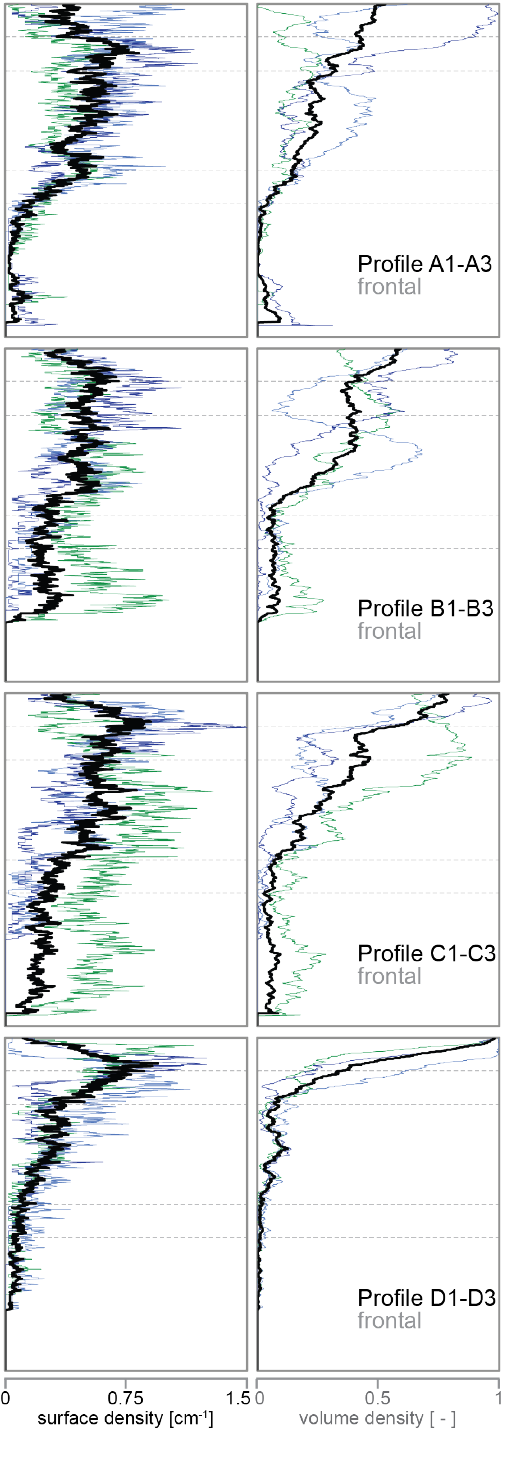
Fig. 7. Numerical representation of the dye-stained soil patterns of the 1m × 1m soil profiles. The integrated frontal profiles A1–A3, B1–B3, C1–C3 are shown on the left, lateral profiles E, F1–F2, G1–G3 and H1–H3 are on the right. Surface density (SD) illustrates the vertical distribution and dimension (size) of dye-stained structures in the soil profiles. Volume density (VD) illustrates the dye coverage per soil depth. The black lines represent the SD or VD of the profile group (one value for A1, A2, A3). The colored lines illustrate the SD or VD of the individual profiles (green, bright blue, dark blue). The dashed gray lines represent the soil horizon boundaries of the gleysol in 0.1/0.2m (H/Go horizon) and 0.5/0.6m depths (Go/Gr horizon).